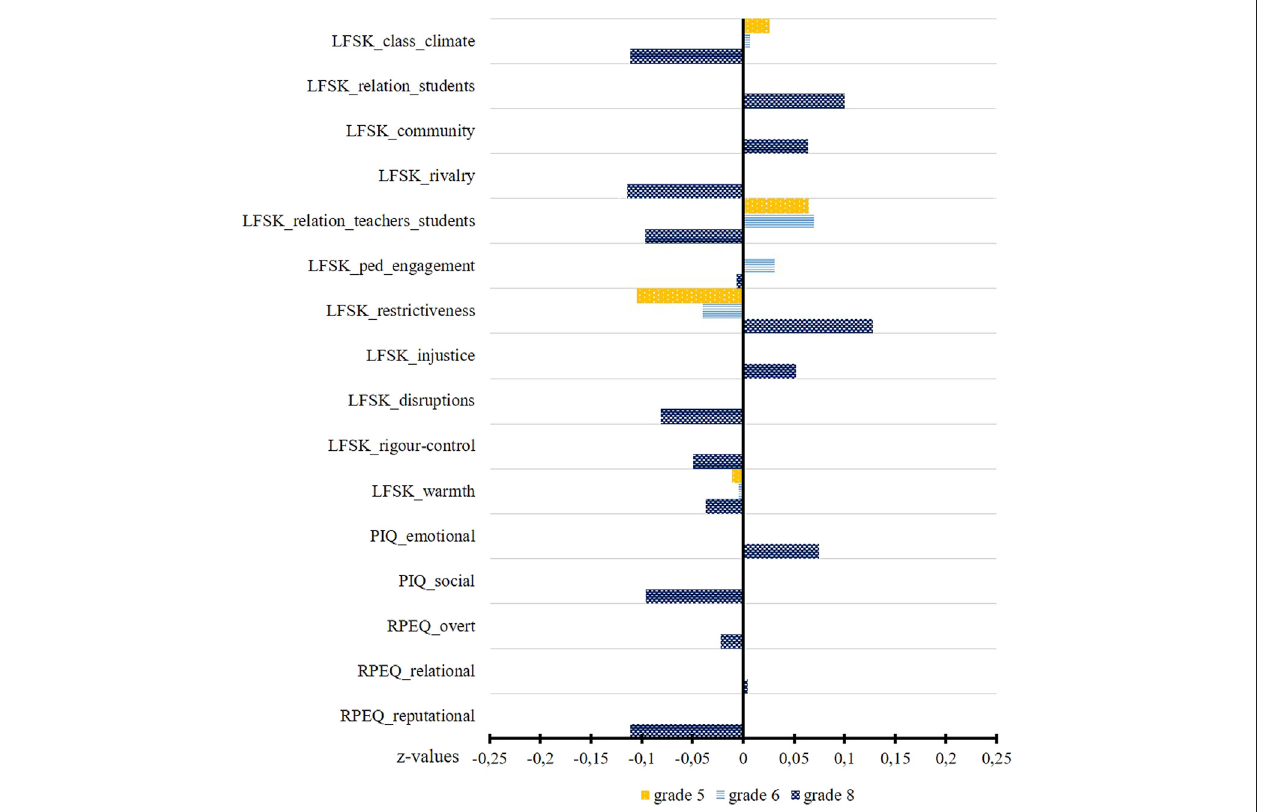
FIGURE 2 | Sensibility for